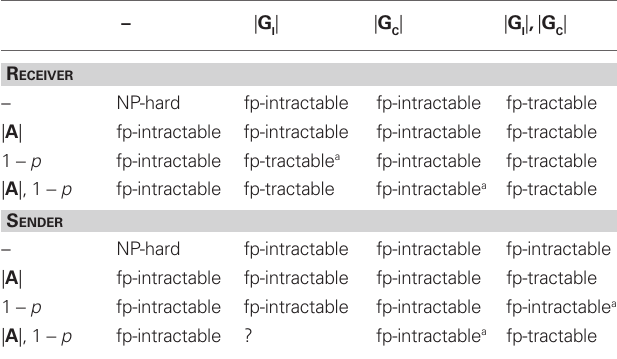
The table lists all possible combinations of parameters from Table 1: each cell stands for the parameter set consisting of its row and column labels. In the special case of the empty parameter set classical (non-parameterized) complexity applies, in this case NP-hardness. Note that in our model | A | = | S | = T. Hence for all listed results including parameter | A | in the parameter set the other two parameters | S | and T may be replaced (or even added) with no change